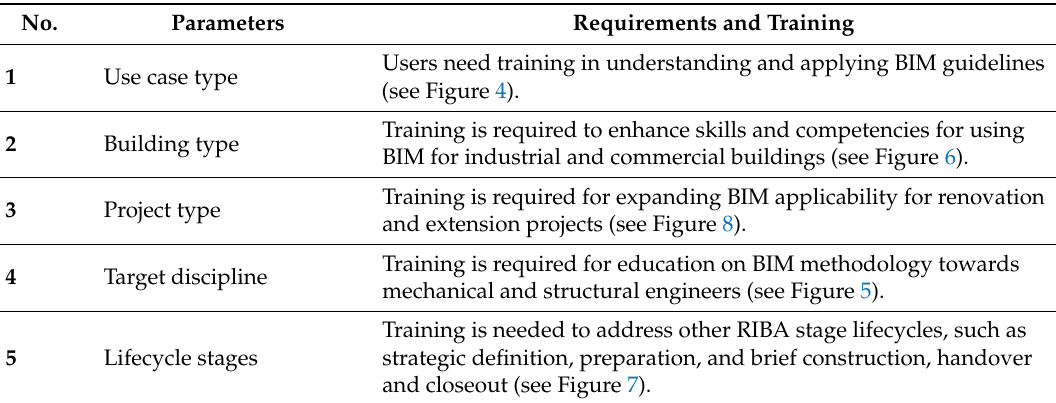
Table 3. Identified requirements based on use cases